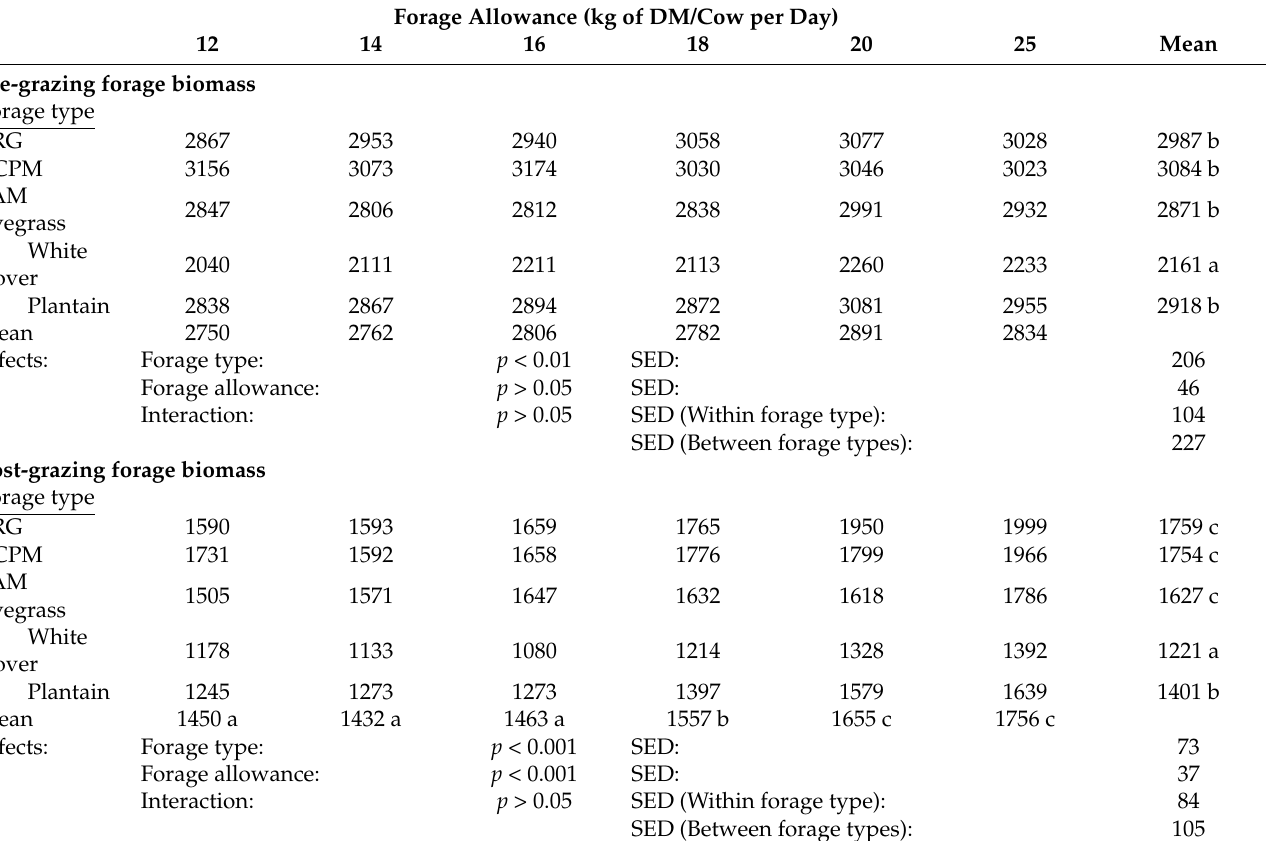
Table 4. Pre- and post-grazing forage biomass (kg of DM/ha) of three forage types allocated to early lactation dairy cows at six forage allowances. Forage types included PRG, perennial ryegrass monoculture; RCPM, perennial ryegrass, white clover and plantain mixture; and SAM, spatially adjacent monocultures of perennial ryegrass, white clover and plantain. Values with different scripts are significantly different ( p <